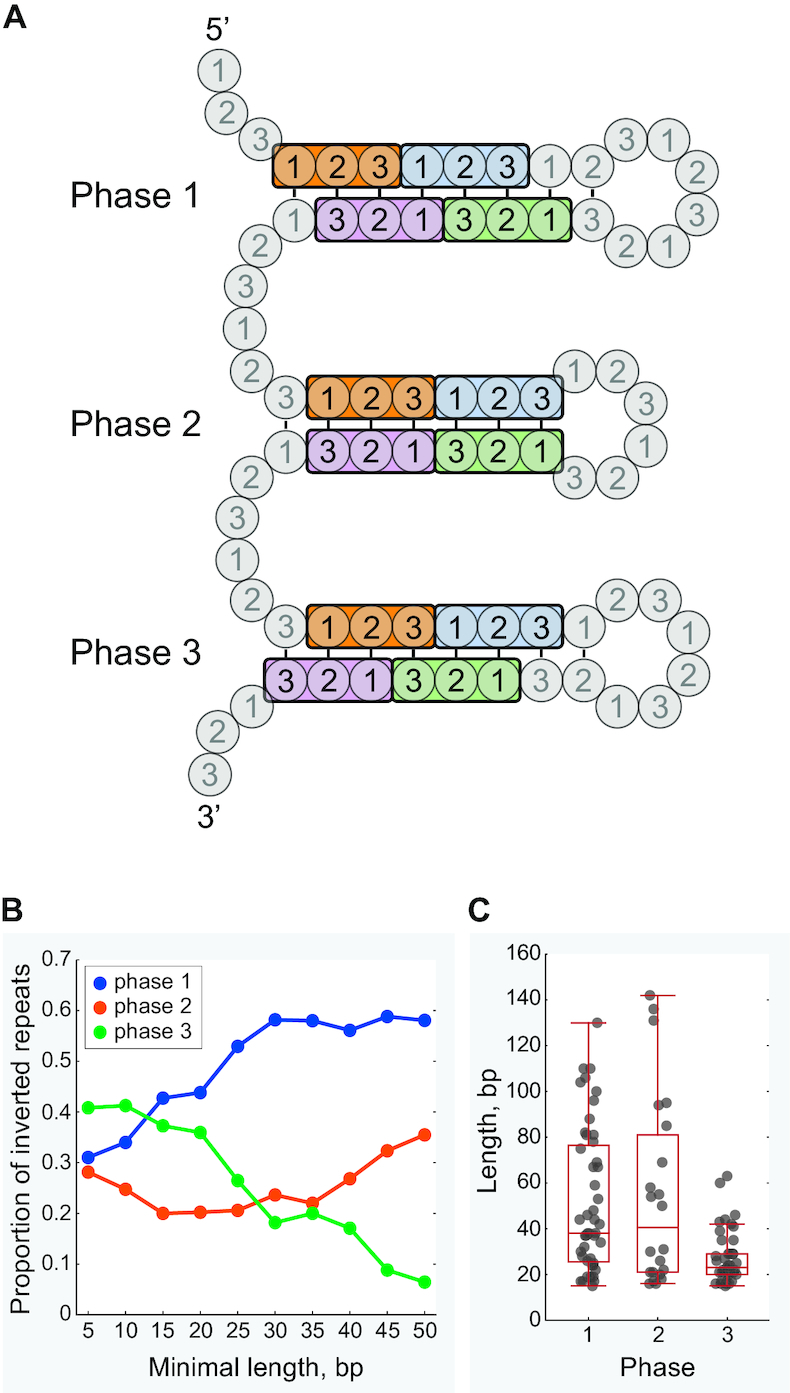
Characterization of the three inverted repeat phases for coding sequences. (A) Three possible relative arrangements of codons in the complementary arms of inverted repeats: phase 1 repeats tie together codon positions 1 between the complementary arms of the repeat, phase 2 repeats tie together codon positions 2 and phase 3 repeats tie together codon positions 3. (B) Dependence of the relative amounts of repeats of each phase on the minimal length of the repeat in the genomes of Nematomorpha; the total number of detected repeats drops from 35 487 at the minimal length of 5 bp to 68 at the minimal length of 25 bp, and to 31 at the minimal length of 50 bp. (C) Distributions of inverted repeat lengths by phase in nematomorph species (for repeats over 15 bp), showing individual repeat occurrences.